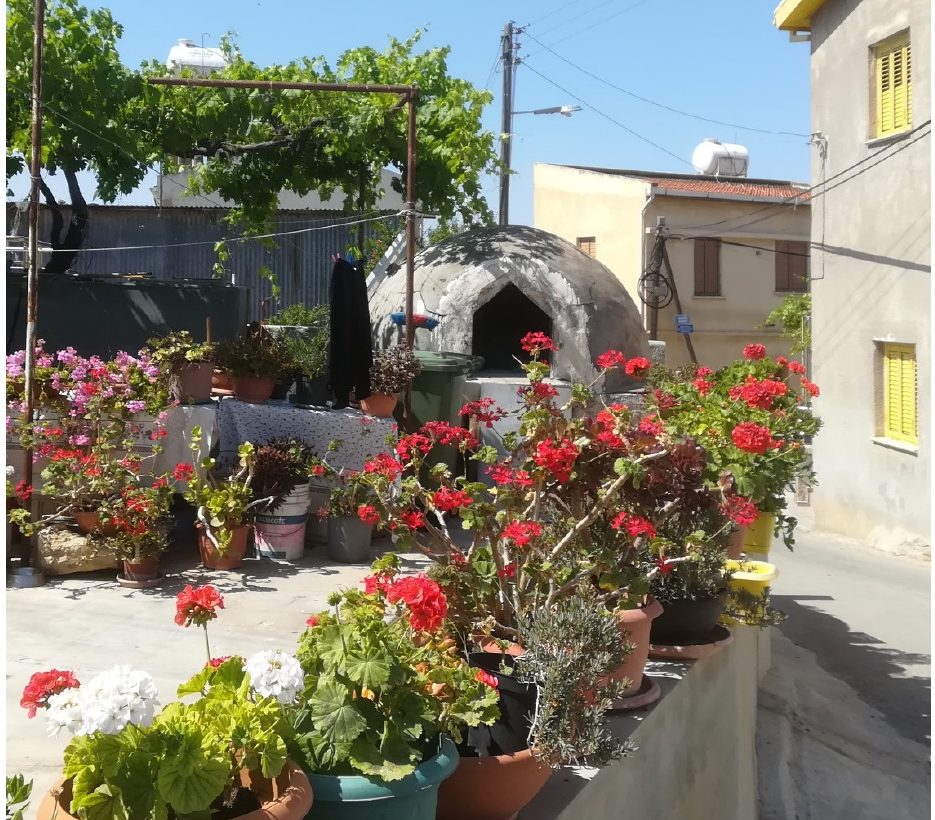
Figure 3. View of the village center, with private courtyard, grape pergola, and traditional external baking oven.